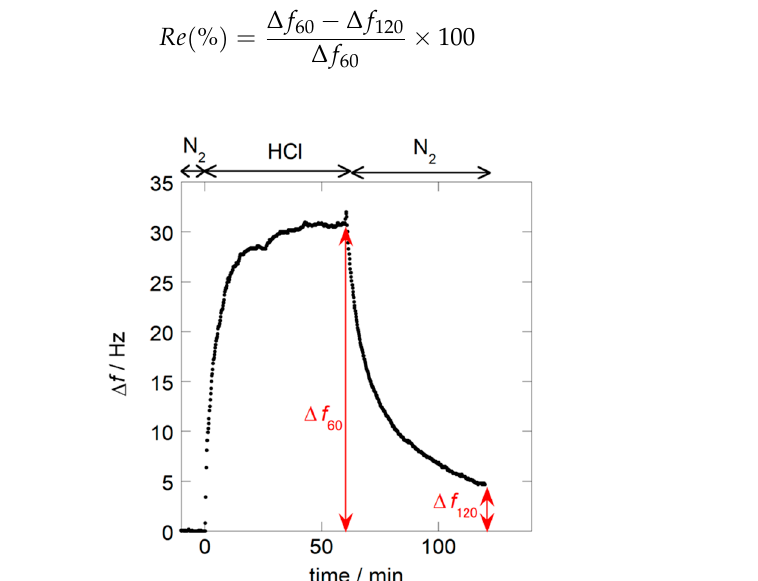
Figure 5. Typical response of the PNIPAM nanoparticle sensor to 98 ppm of HCl/N 2 at 30 °C.